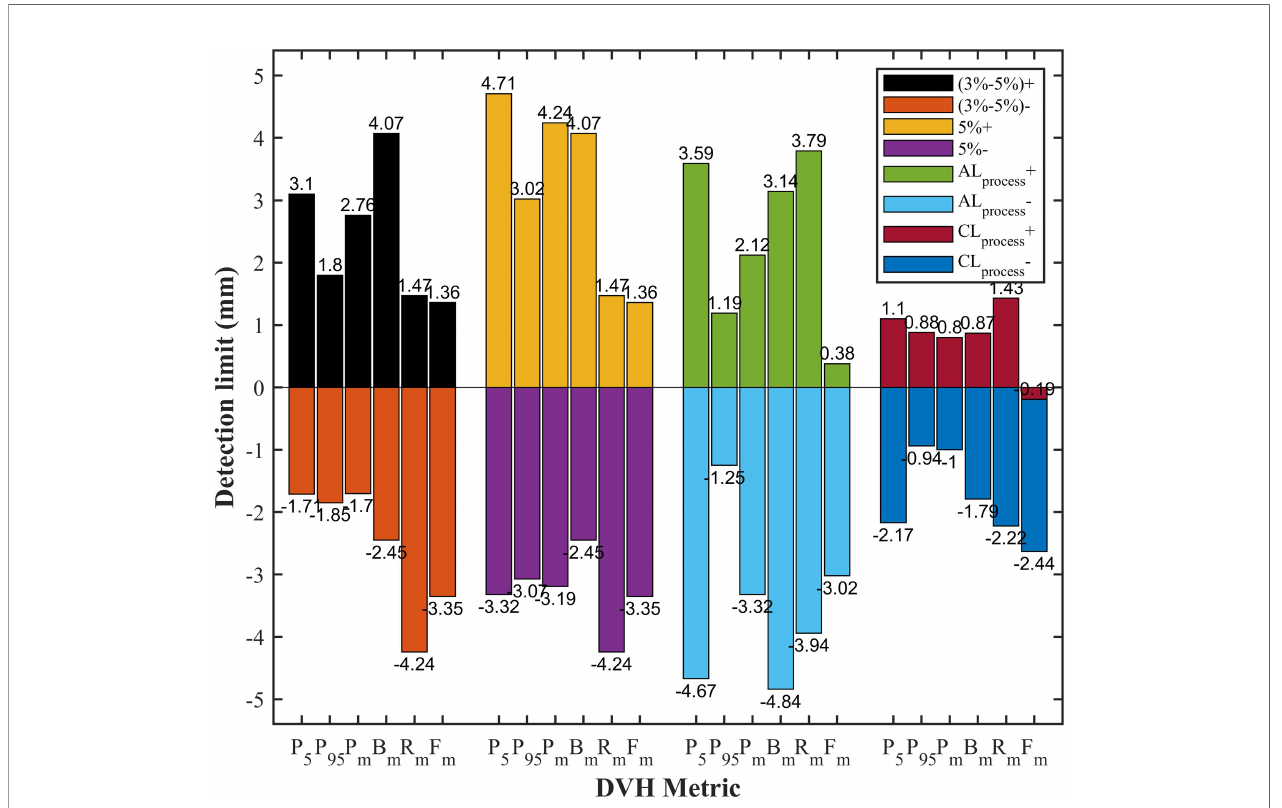
FIGURE 5 | The comparison of detection limits in different DVH-based action levels. P 5 , PTV 5 ; P 95 , PTV 95 ; P m , PTV mean ; B m , Bladder mean ; R m , Rectum mean ; F m , Femoral-heads mean ; (3%-5%)+, 3% DVH action levels for target volume and 5% DVH action levels for OARs in positive direction; (3%-5%)-, 3% DVH action levels for target volume and 5% DVH action levels for OARs in negative direction; 5%+, 5% DVH action levels for target volume in positive direction; 5%-, 5% DVH action levels for target volume in negative direction; AL process +, process-based action limits in positive direction; AL process -, process-based action limits in negative direction; CL process +, process-based tolerance limits in positive direction; CL process -, process-based tolerance limits in negative